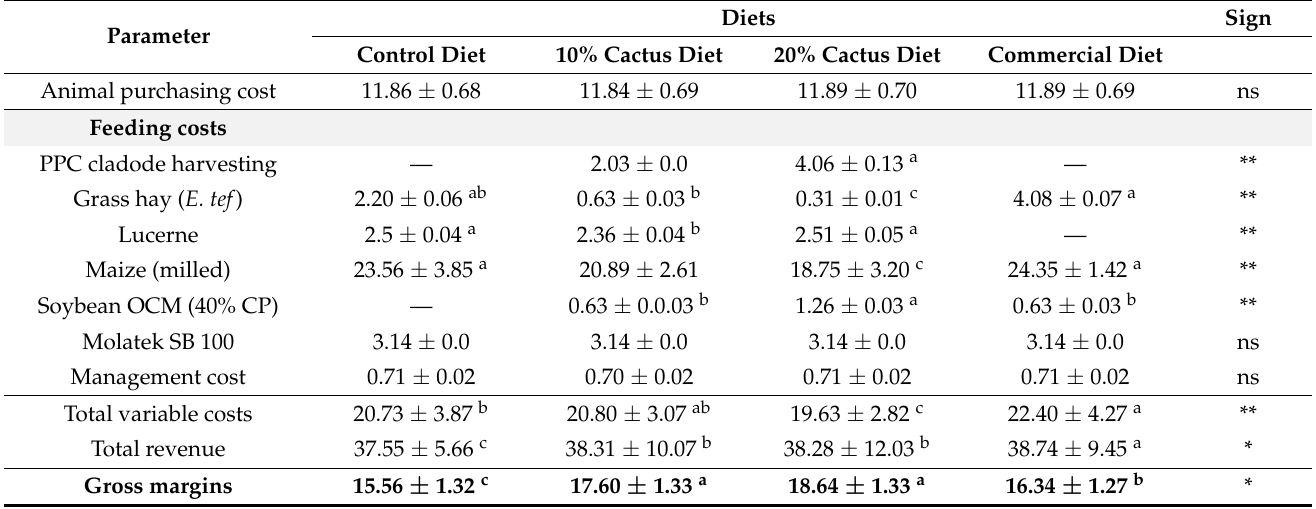
Table 5. Gross margins [cost(USD)/animal] for Nguni heifers fed cactus containing diets.